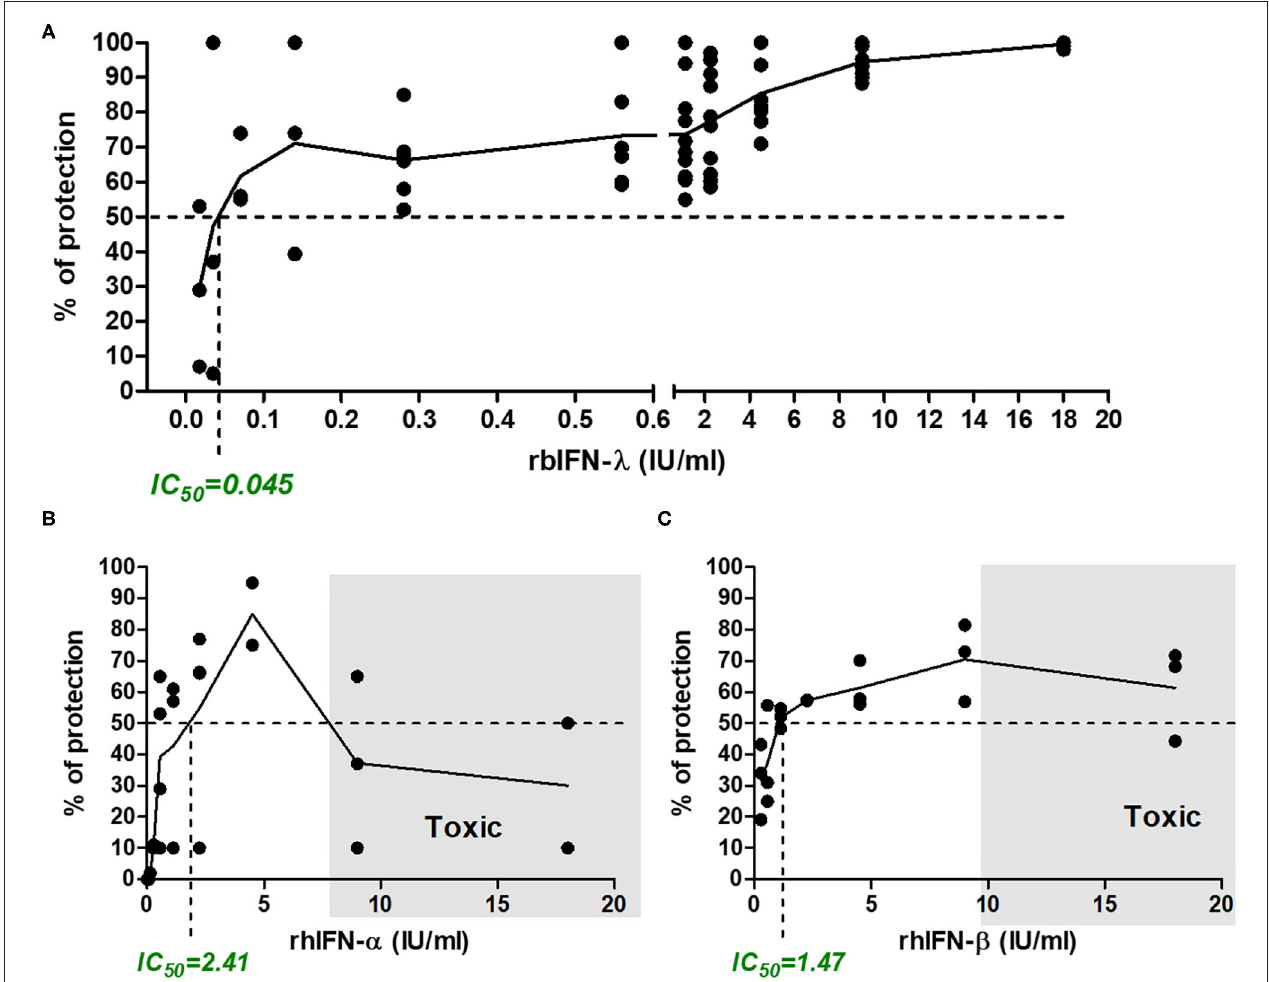
FIGURE 3 | Antiviral activity of bovine rIFN- λ in VERO cells infected with SARS-CoV-2. VERO cells were treated with serial dilutions of bovine rIFN- λ (A) , human rIFN- α (B) , or human rIFN- β (C) . After an ON incubation, cells were infected with SARS-CoV-2 (MOI = 0.5) and incubated for 48h, when cytopathic effect was detected in untreated cells. Antiviral activity was estimated by staining the cell monolayers with crystal violet and reading the resulting OD at 575nm. Percentage of protection was referred to values of mock-treated and infected cells. Toxicity controls were run in parallel in every experiment on treated uninfected cells. The inhibitory concentration 50% (IC 50 , concentration required to inhibit SARS-CoV-2 infection in 50% of the replicates analyzed) is indicated in each chart. Shaded areas depict the toxic concentration range, defined as the concentration of IFN that induces a loss of viability in uninfected cells (a cytopathic-like effect is observed microscopically in IFN-treated but not infected wells, with an increasing number of dead cells, which is related to the low-OD 575-nm